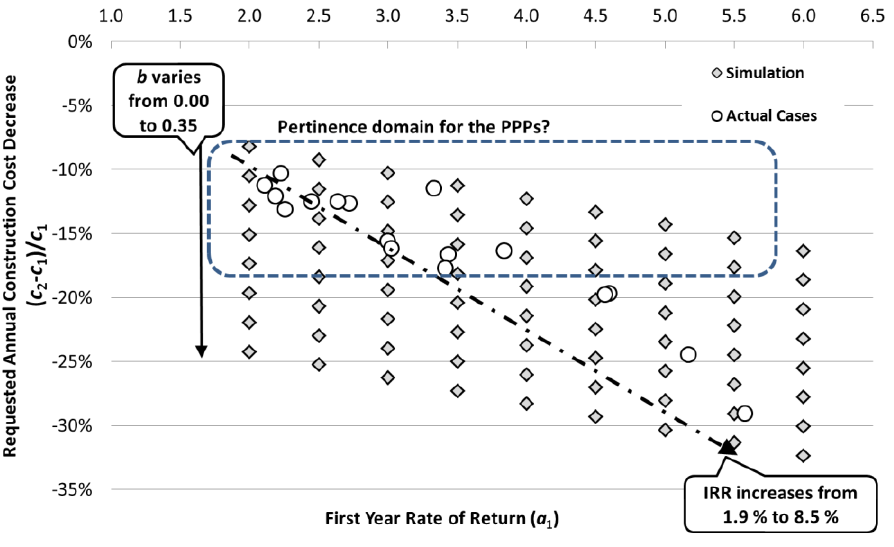
Figure 7. Gain in efficiency on the construction costs c